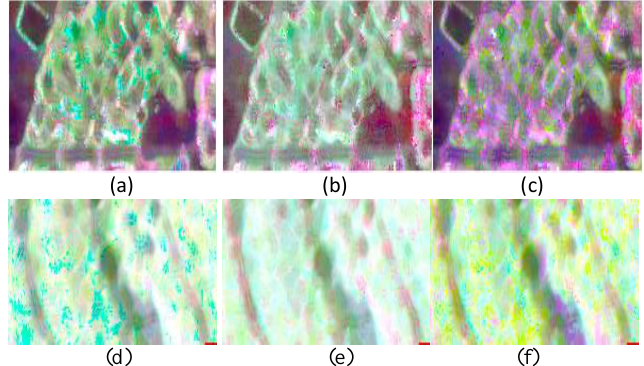
Fig. 3. Decomposition results for patches. (a)- (c) are results of Patch A, (d)-(f) are results of Patch B, processed by Freeman, Yamaguchi and the proposed methods